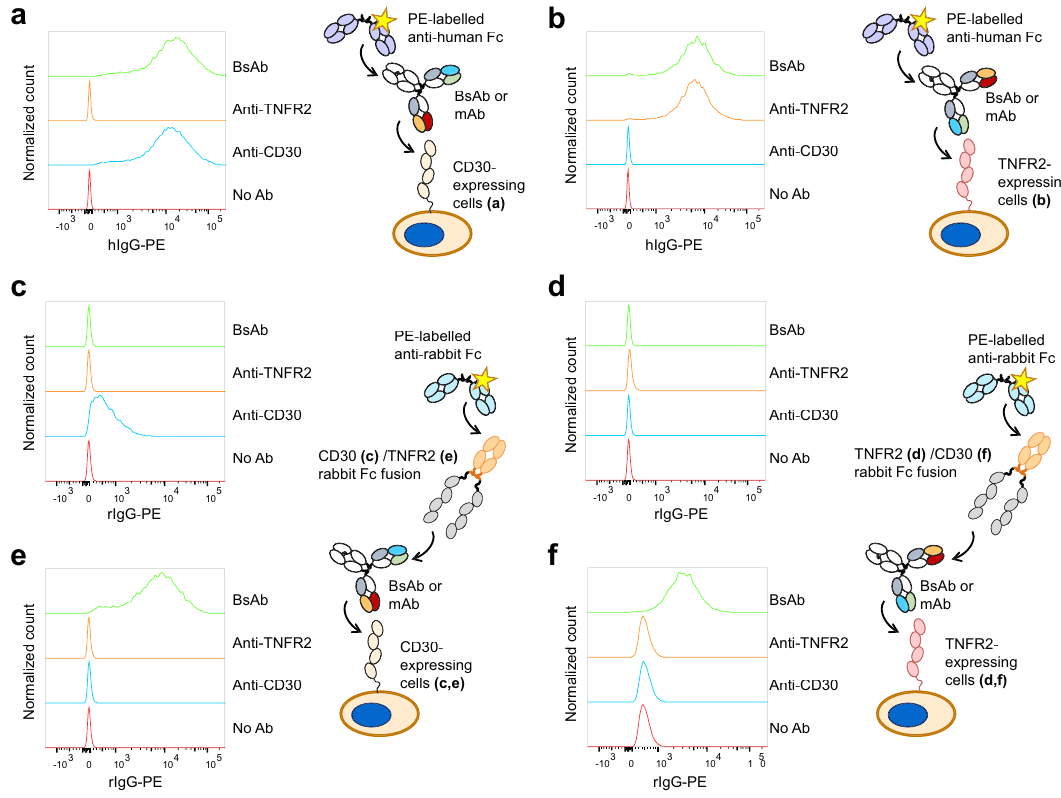
Figure 5. Cellular systems to analyze bispecific binding monitored using flow cytometry. Right shift of the population indicates binding. a,b) Interaction of the mAbs and the BsAb with the cells expressing CD30 (a) and TNFR2 (b) . ( c–f ) Crosslinking of the antigen-expressing cells and recombinant antigen protein using the mAbs and BsAb, analyzed using recombinant TNFR2 and CD30 fused to rabbit Fc (rFc). ( c ) CD30-RB and CD30-rFc, ( d ) TNFR2-RB and TNFR2-rFc, ( e ) CD30-RB and TNFR2-rFc, ( f ) TNFR2-RB and